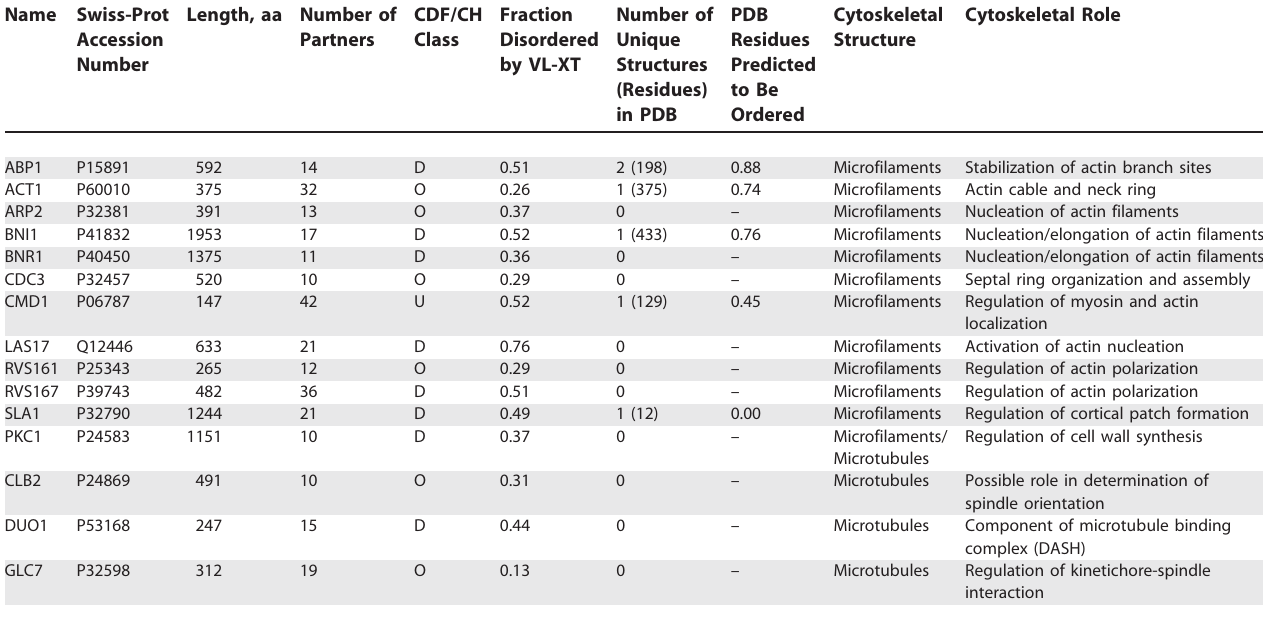
Table 4. Structural and Functional Features of Yeast Cytoskeletal Hubs Name Swiss-Prot